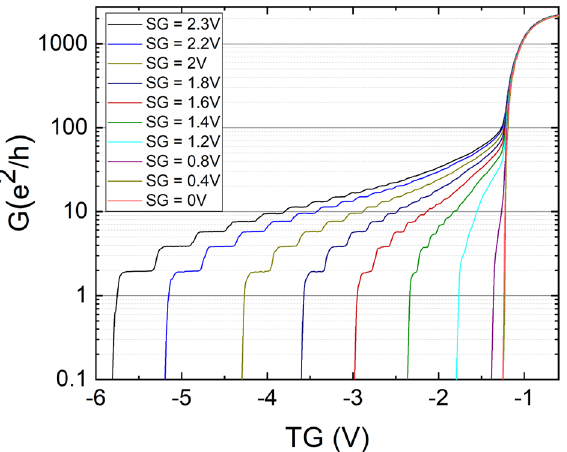
Figure 2. Dependence of conductance on the top-gate (TG) voltage for different side-gate (SG) voltages. At higher side-gate voltages 1D transport behavior on a cleaved edge deposition sample over a 2 μm wide wire at 25 mK with an excitation of 6 μV can be induced.